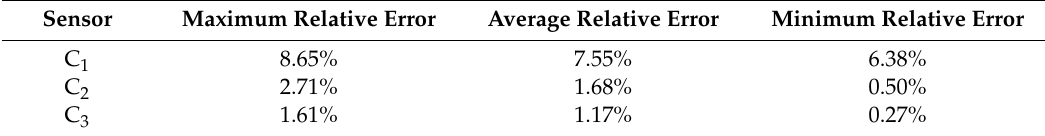
Figure 13. Comparison of the temperature histories of C 3 between the coupling model and the experiment. Table 4. Comparison of coupling model and experiment.